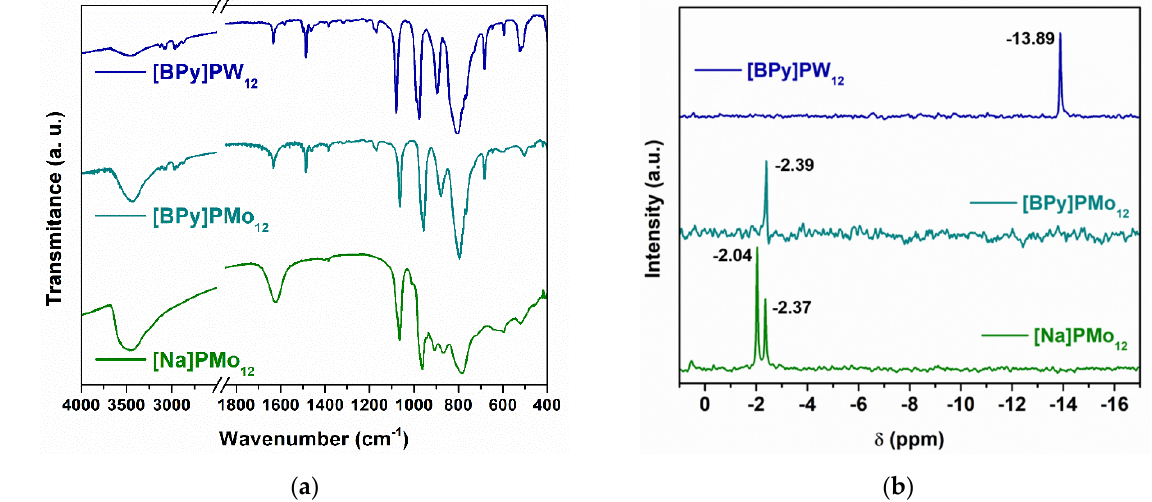
Figure 1. ( a ) FT-IR spectra showed in the wavenumber regions 4000–2500 cm − 1 and 1800–400 cm − 1 , and ( b ) 31 P NMR spectra showed in the chemical shifts ranging from 1 to − 17 ppm, obtained for [Na]PMo 12 , [BPy]PMo 12 , and [BPy]PW 12 .